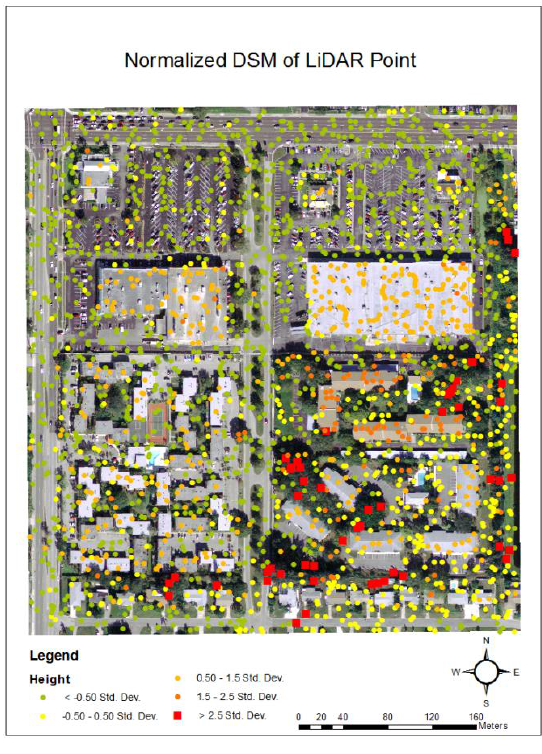
Figure 5. Normalized DSM